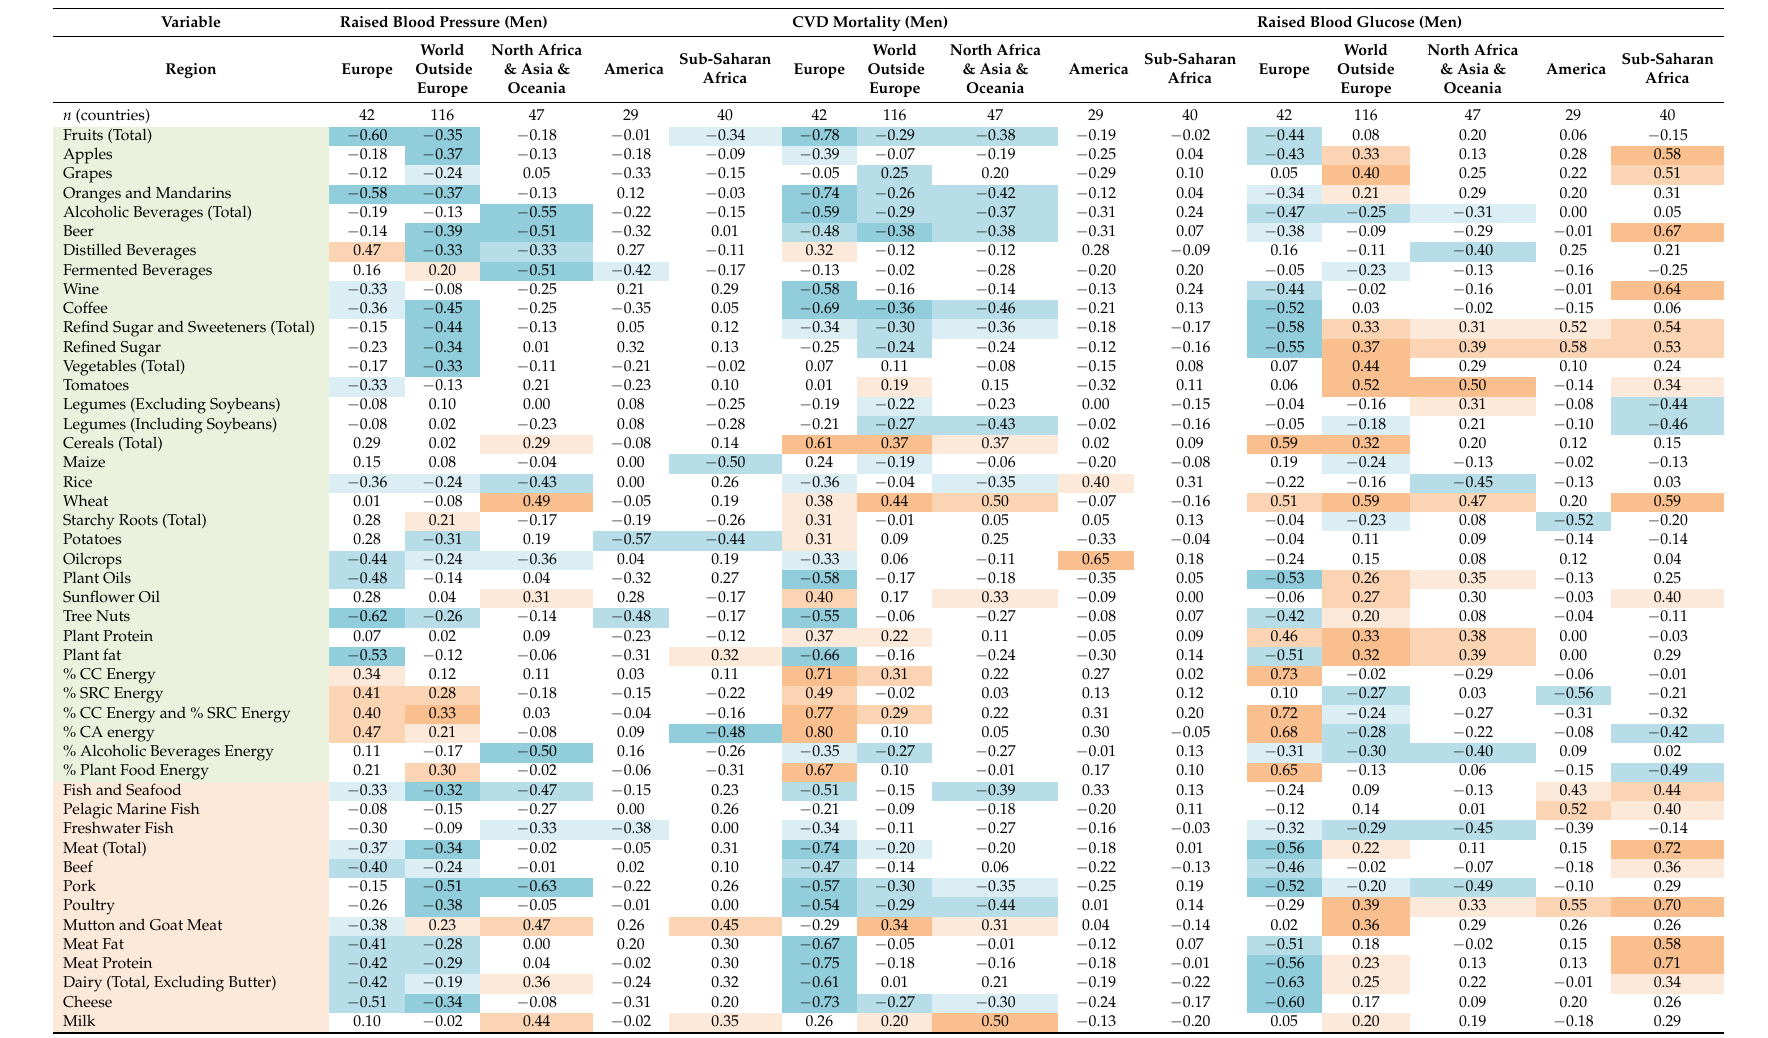
Table 2. Pearson linear correlations in men: regional